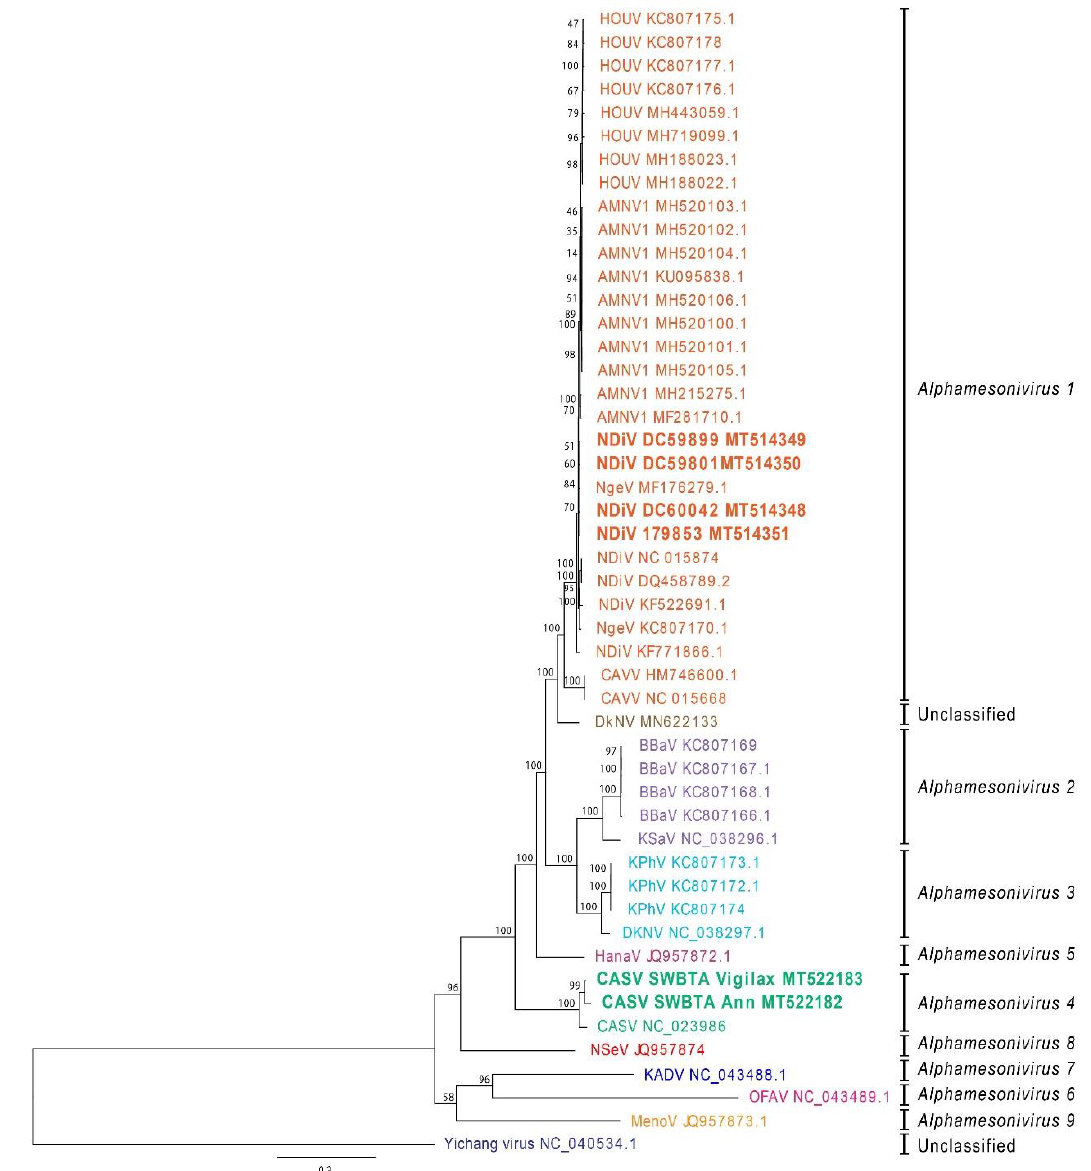
Figure 1. Phylogenetic analysis of the new mesonivirus sequences with other members of the Mesoniviridae . The tree was constructed in Geneious (Auckland, New Zealand) using MrBayes v3.2.2 under the Bayesian Marko chain Monte Carlo (MCMC) model with General Time Reversible (GTR) substitution model, gamma distribution (five discrete gamma categories) and invariant rates among sites [24] using available nucleotide sequences for virus genomes that were coding-complete. Horizontal branch lengths represent posterior probabilities. Bolded text indicates new Australian Alphamesonivirus 1 isolates (179853 (NSW), DC59899 (WA), DC59801 (WA), DC60042 (WA)) and Alphamesonivirus 4 isolates (SWBTA Vigilax and SWBTA Ann, both from Qld.). Scale bar indicates substitutions per site.